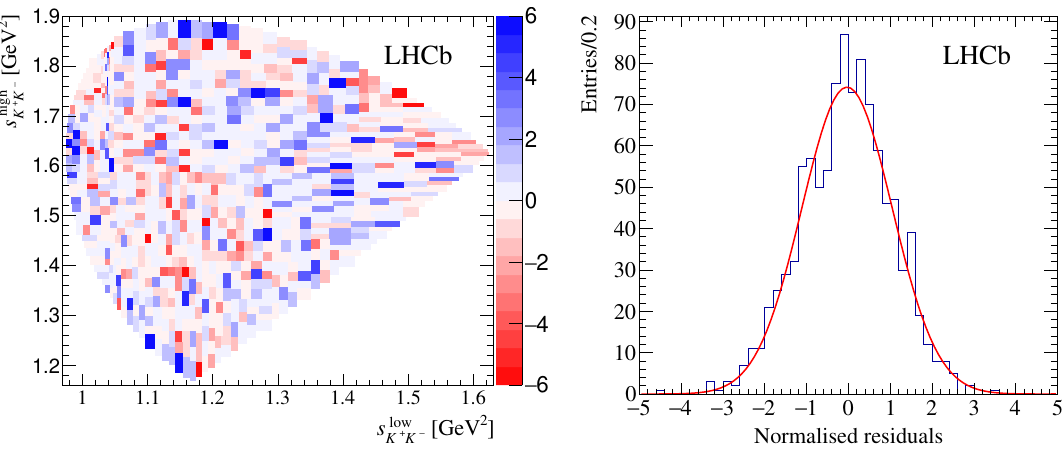
Figure 7 . (left) Normalised residuals (cid:1) i across the Dalitz plot, from the result of isobar (cid:12)t. (right) Distribution of the normalised residuals with the (cid:12)t result overlaid. The distribution is (cid:12)tted with a Gaussian function and the (cid:12)t result is consistent with the standard normal distribution.